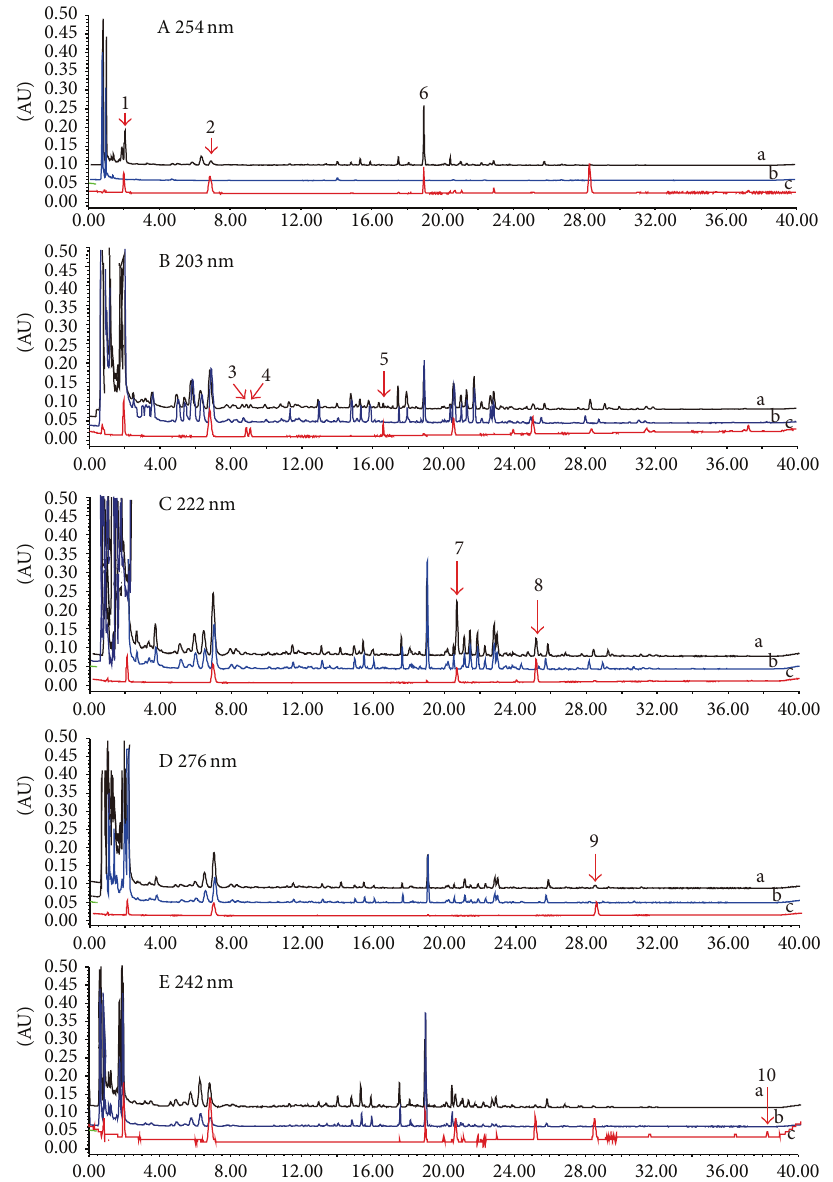
Figure2:Ultraperformanceliquidchromatography(UPLC)chromatogramsatdifferentwavelengthsofstandardmixture(a),SJZTextraction (b), and negative control samples (c). Peaks: (1) liquiritin, (2) liquiritigenin, (3) ginsenoside Rg 1 , (4) ginsenoside Re, (5) ginsenoside Rb 1 ,